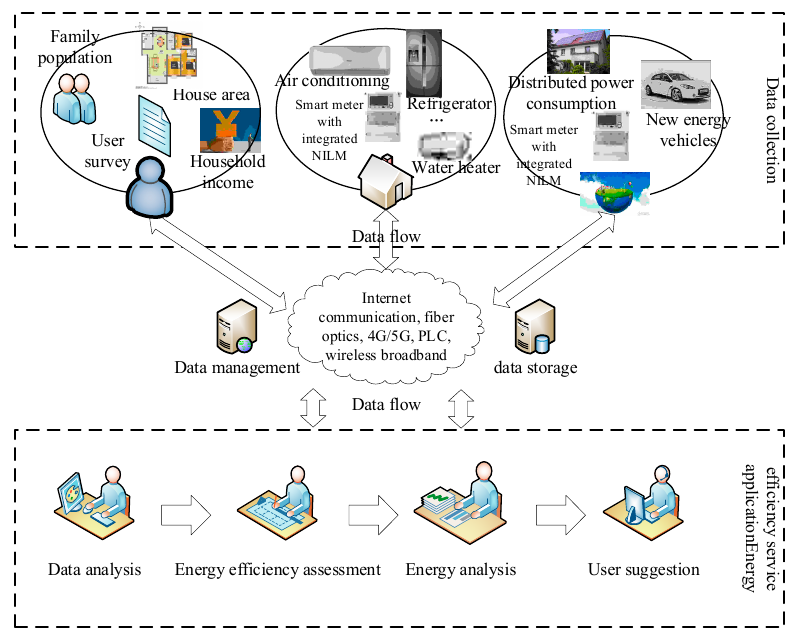
Figure 1. Residential user energy efficiency assessment framework.